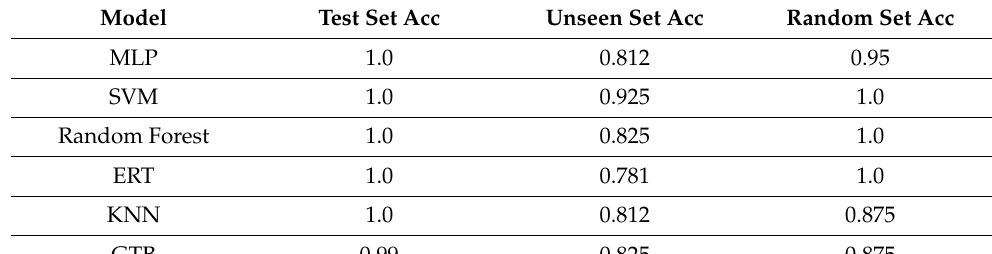
Table 2. Accuracy of classification models for RF features.